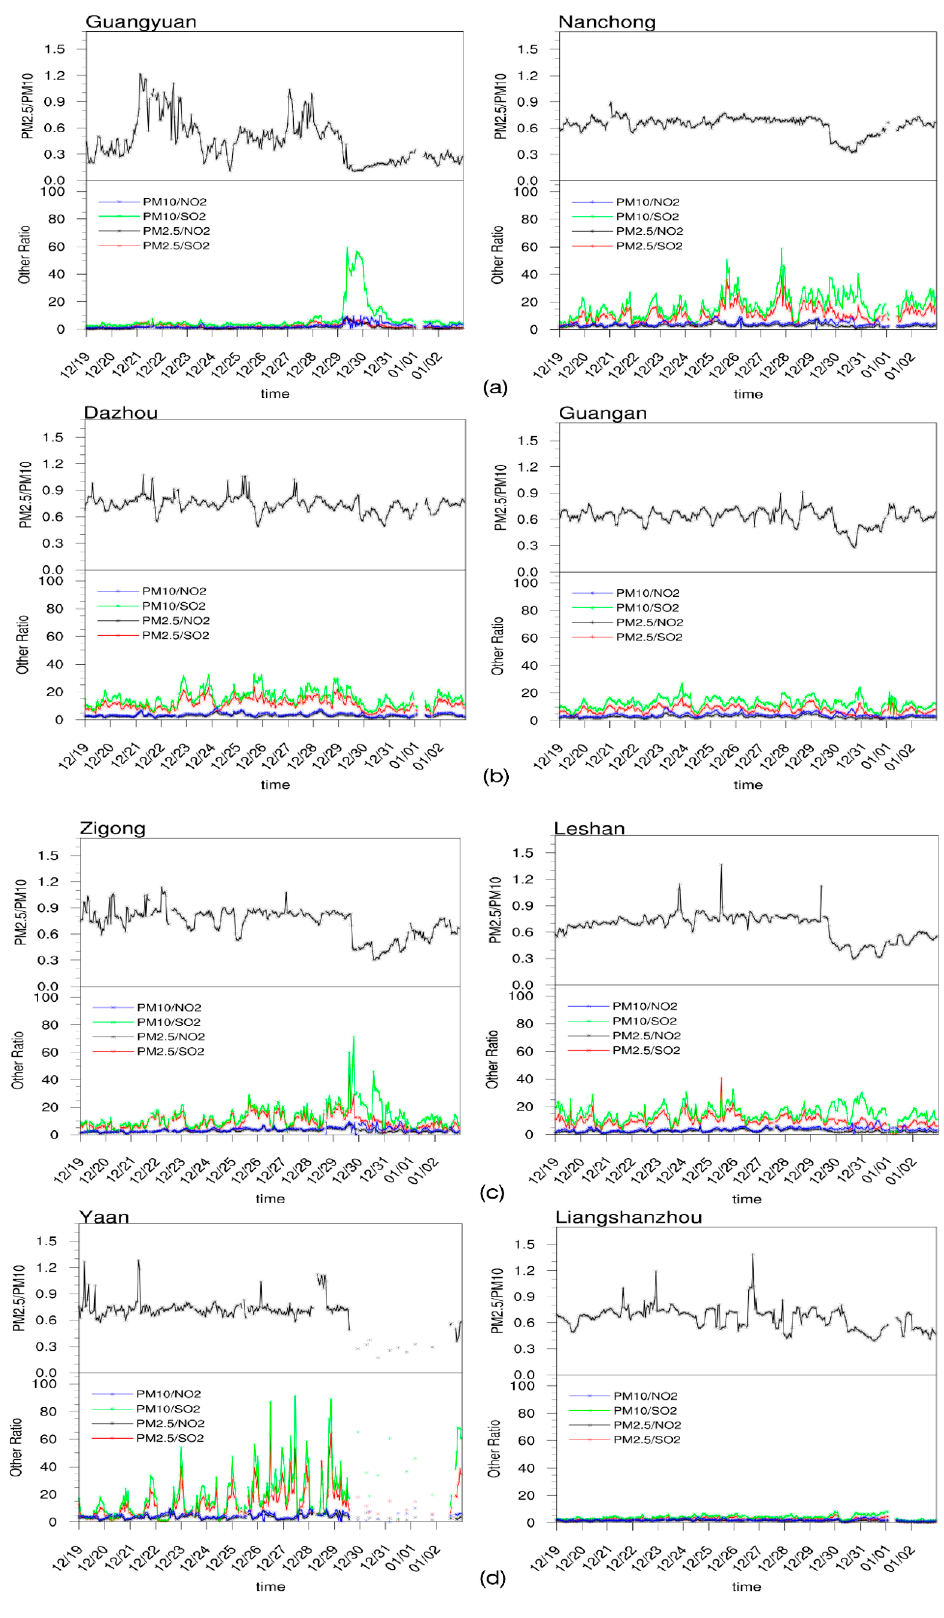
Figure 4. Variations in the pollutants’ ratios in the eight cities in northern Sichuan ( a ), eastern Sichuan ( b ), southern Sichuan ( c ) and western Sichuan ( d